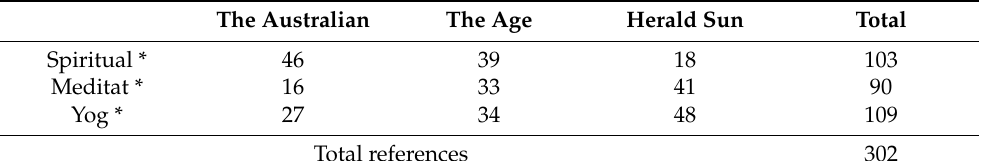
Table 10. Common religion references across the